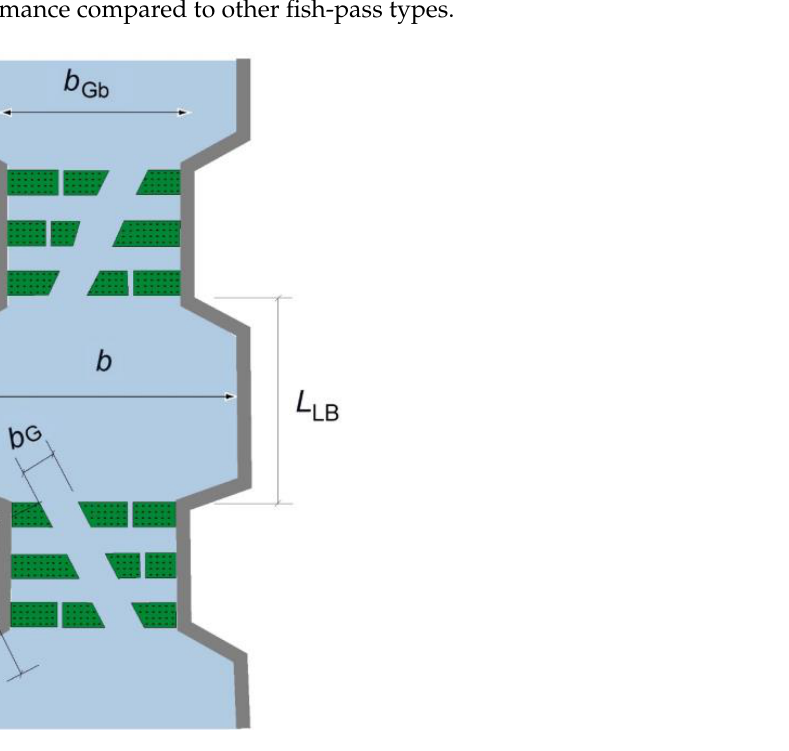
Figure 1. Illustration of diagonal-type brush fish-pass arrangement adopted from DWA [6]. b = pool width, b G = alley width at bristle passes, b Gb = free channel width at bristle passes, L G = length of the alley at bristle passes, and L LB = pool length.